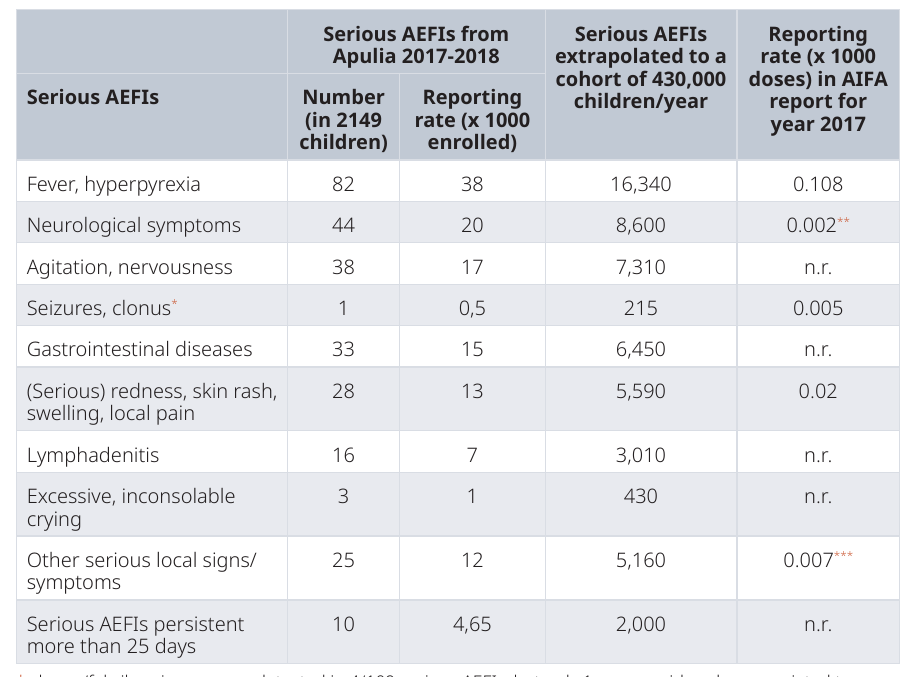
Table 1. Serious adverse events following immunization (AEFIs) consistently causally associated with measles-mumps-rubella-varicella (MMRV) vaccination according to Stefanizzi et al . 3 and to the AIFA report for year 2017 13